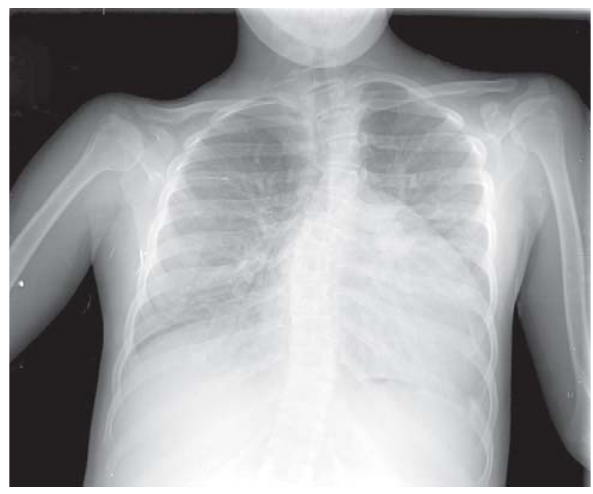
Fig. 2 – Radiografia de tórax com aumento de área cardíaca e sinais de hiperfluxo pulmonar